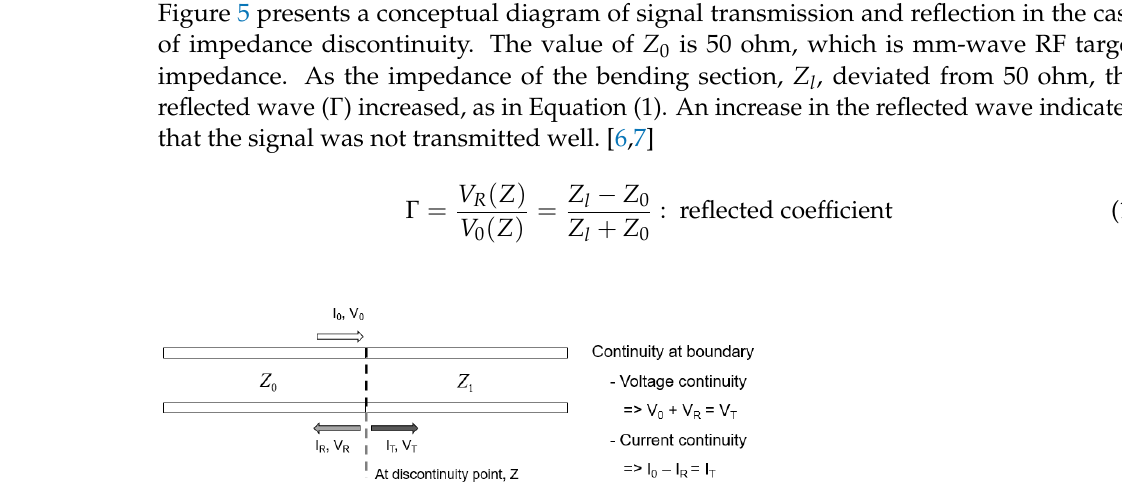
Figure 5. Conceptual diagram of signal transmission and reflection in case of impedance disconti- nuity.